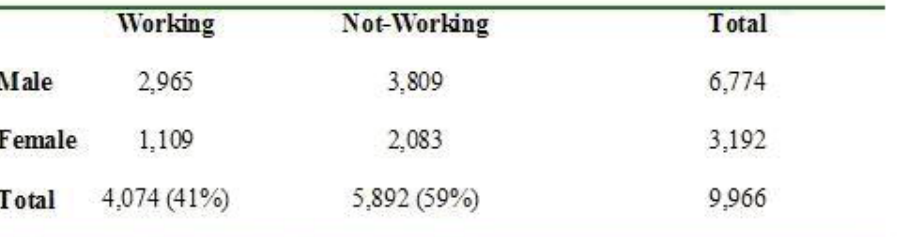
Table 2. Employment Status of NOUN